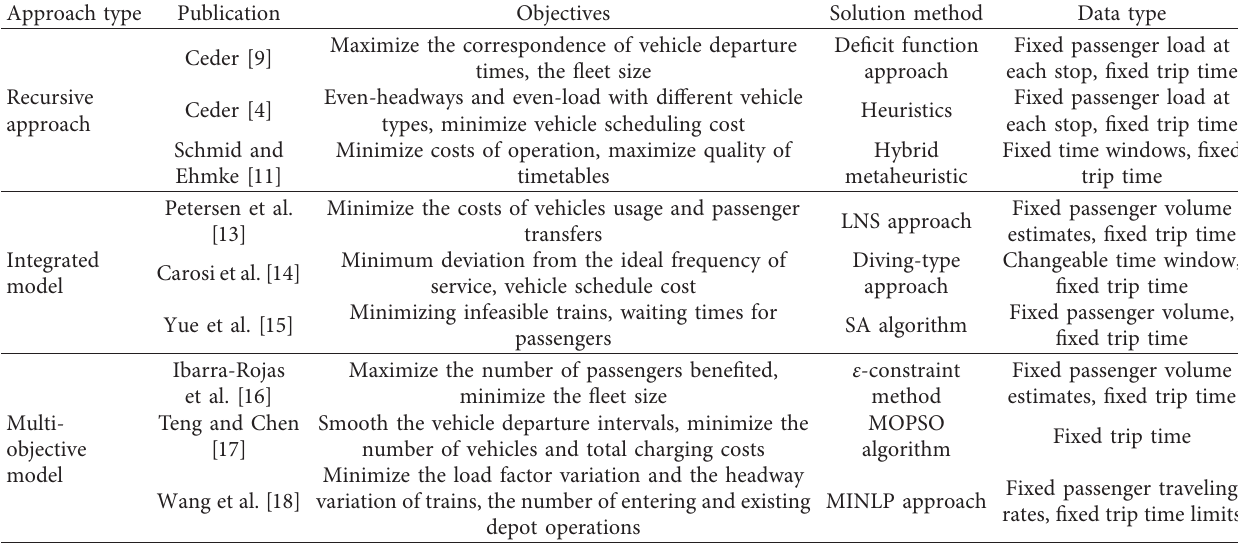
Table 1: Summary of relevant studies on the integration of TTP and